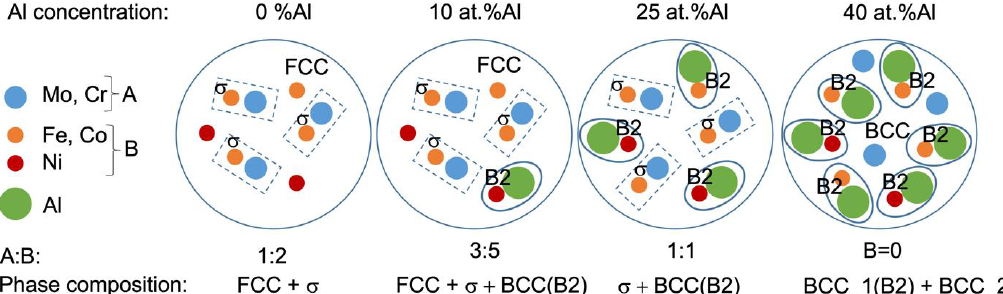
Figure 7. Atom distribution and the formation of the phase composition scheme. The indicated A:B ratio refers to the atoms, which are not bound with Al.